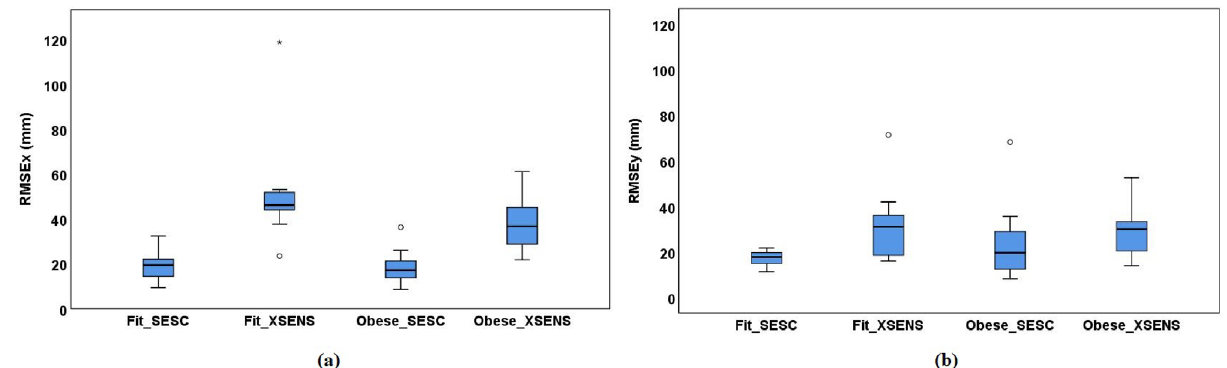
Figure 2. Box and Whisker plots for the RMSE values of SESC and XSENS CoM estimations along the AP-axis ( a ) and ML-axis ( b ) for both Fit and Obese groups. IQRs are represented by the blue boxes, median values are indicated by the bars within the boxes, the whiskers represent the minimum and maximum ranges, and the dots represent the